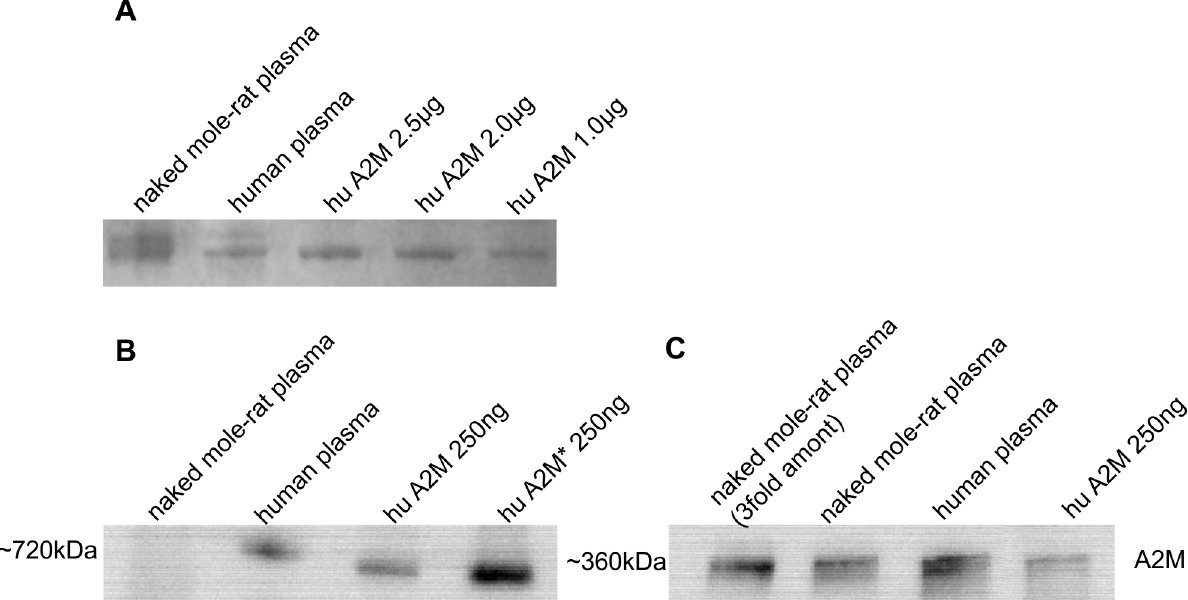
Fig 4. Western blot of plasma from NMR and human for alpha-2 macroglobulin. The determination of A2M in plasma samples was performed by electrophoresis in 7% SDS-gel using NMR and human plasma, 30 μ g each, and purified human A2M (1 – 2.5 μ g). A2M was quantified by Commassie staining using isolated human A2M to prepare a calibration curve (A). Western blot analyses using a native gradient PAGE (4 – 20%) was applied to detect the transformed form of A2M using the alpha-1 antibody (B) and a 7% non-reducing SDS-PAGE to detect A2M with a polyclonal antibody using 9 and 3 μ g NMR or 3 μ g human plasma and 250 ng isolated human A2M